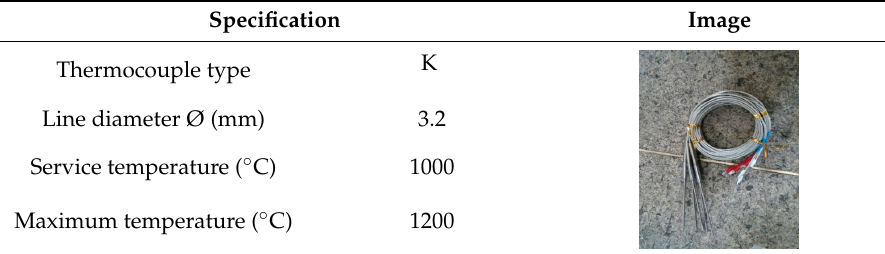
Table 2. Specification and image of the sensor.